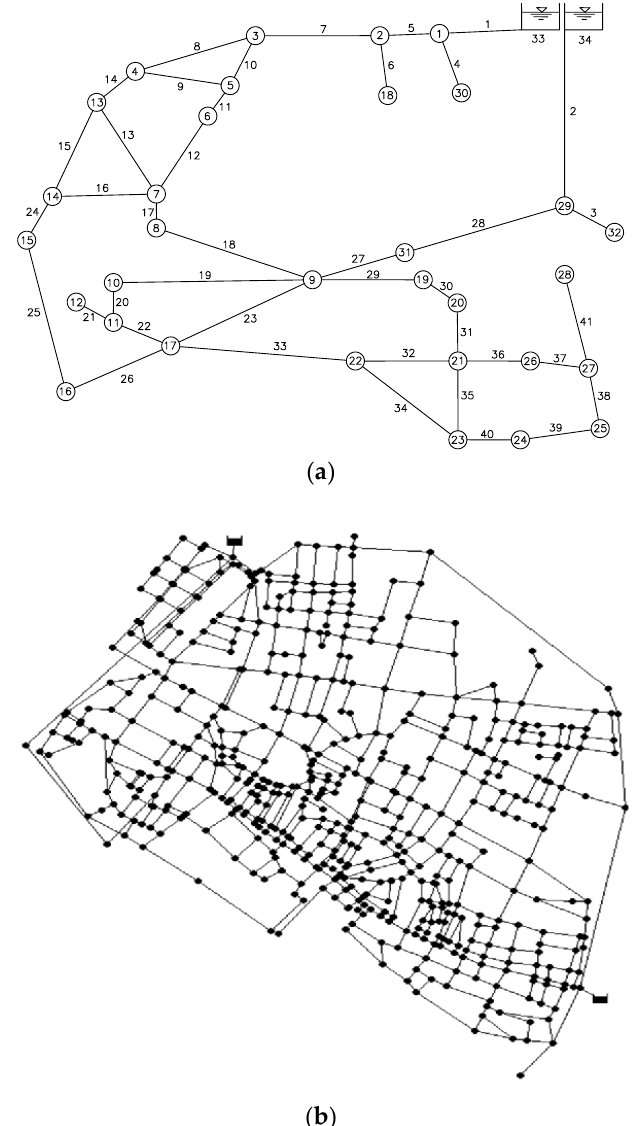
Figure 2. Water distribution networks (WDNs) for the two case studies ( a , b ). In the first case study with source nodes 33 and 34, pipe numbers are close to the pipes and the numbers of demanding nodes are inside circles.